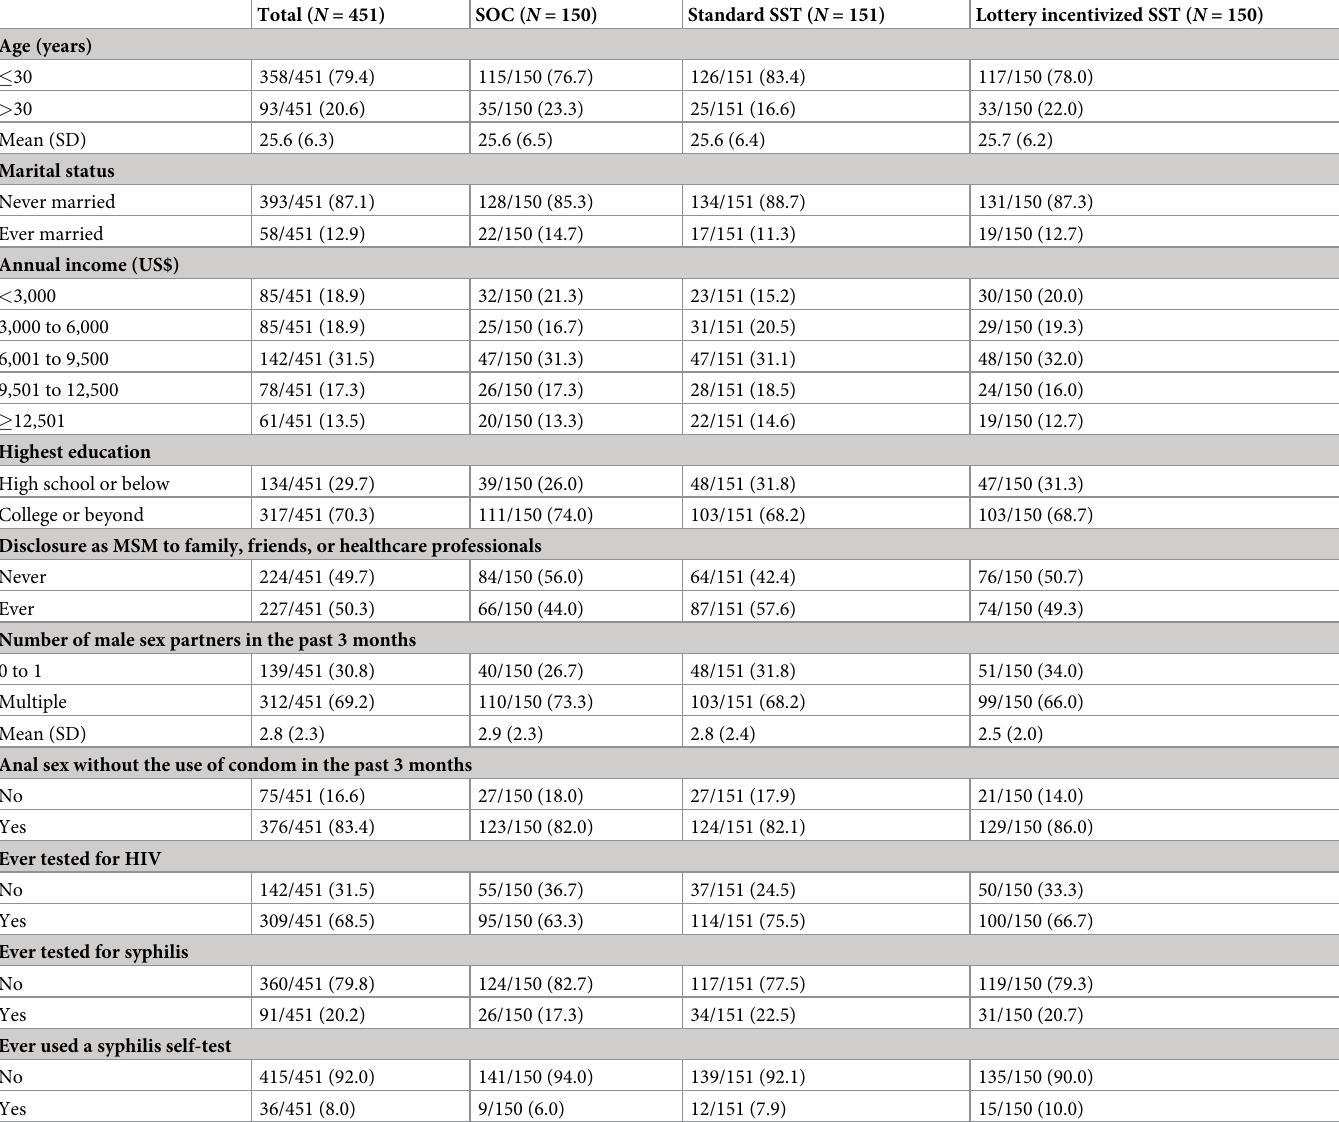
Table 1. Baseline social demographic and behavioral characteristics of MSM in